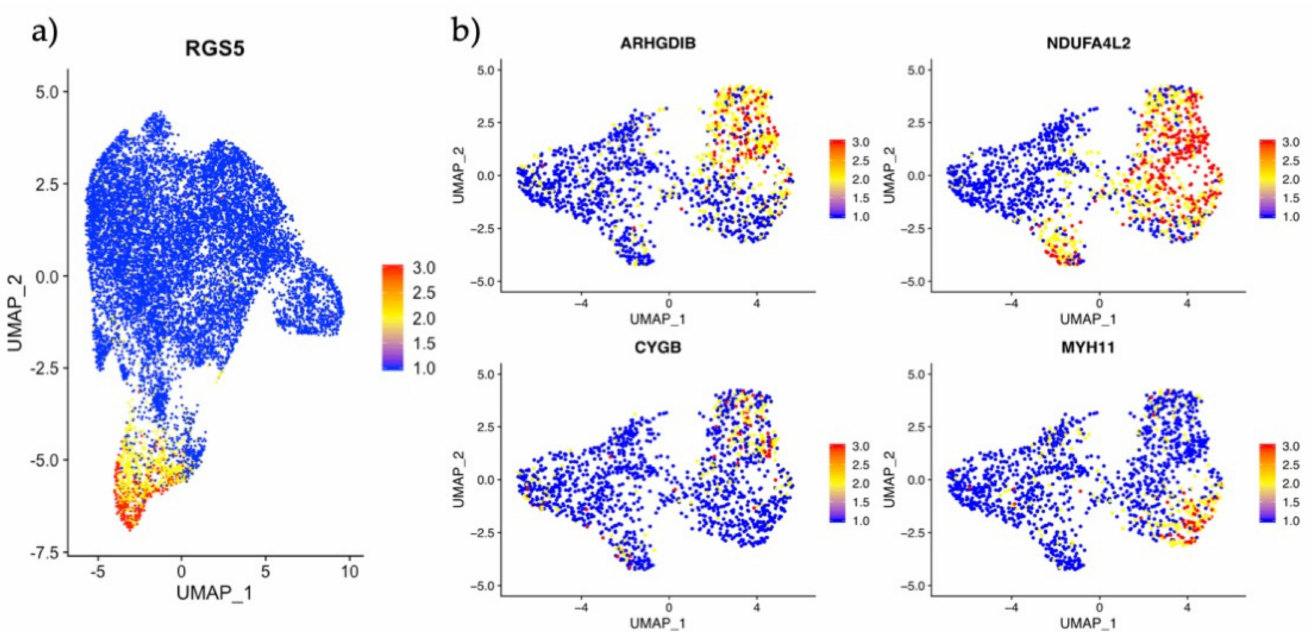
Figure 6. Analysis and identification of endometrial pericyte subtypes in the maternal-fetal interface. ( a ) Scatter plot showing RGS5 expressing cells in the UMAP projection. ( b ) Scatter plot of selected RGS5+ cells and their scaled gene expression of CYGB, ARGHDIB, NDUFA4L2 and MYH11 identifying the top right cells as Pericyte1 and the bottom right cells as